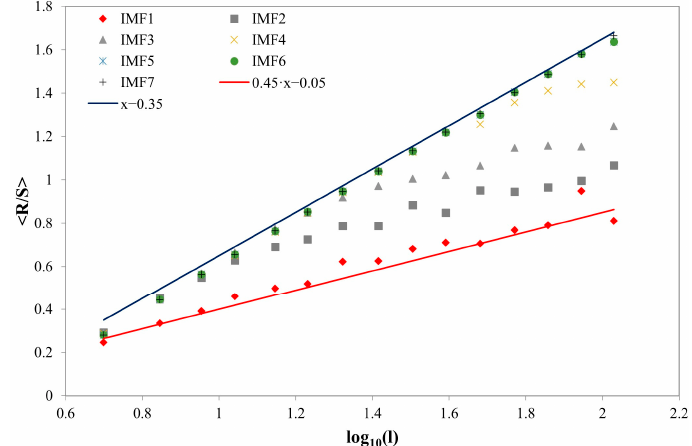
Figure 5 . Hurst analysis for the reconstructed humification timeseries. Figure 5. Hurst analysis for the reconstructed humification